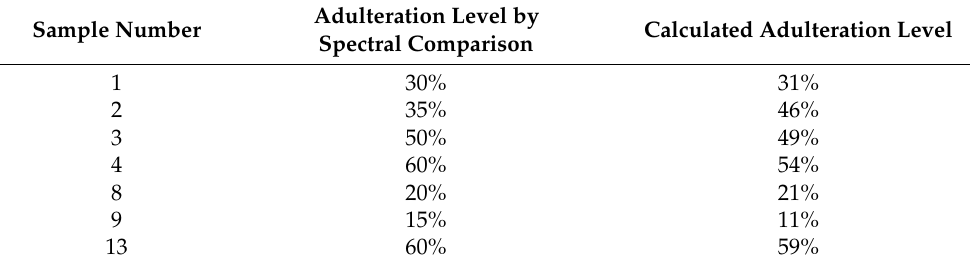
Table 3. Calculated levels of palm oil in adulterated